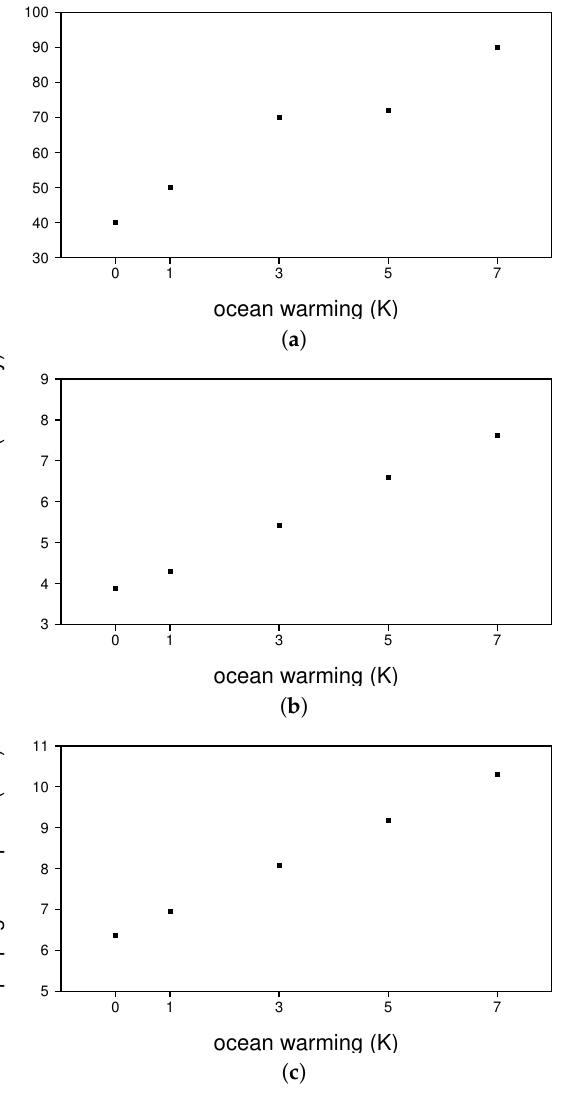
Figure 5. Dependence of MJO characteristics on the amount of ocean warming in LAM simulations: ( a ) frequency of occurrence; ( b ) maximum rain rate in rainfall time series; and ( c ) propagation speed in rainfall time